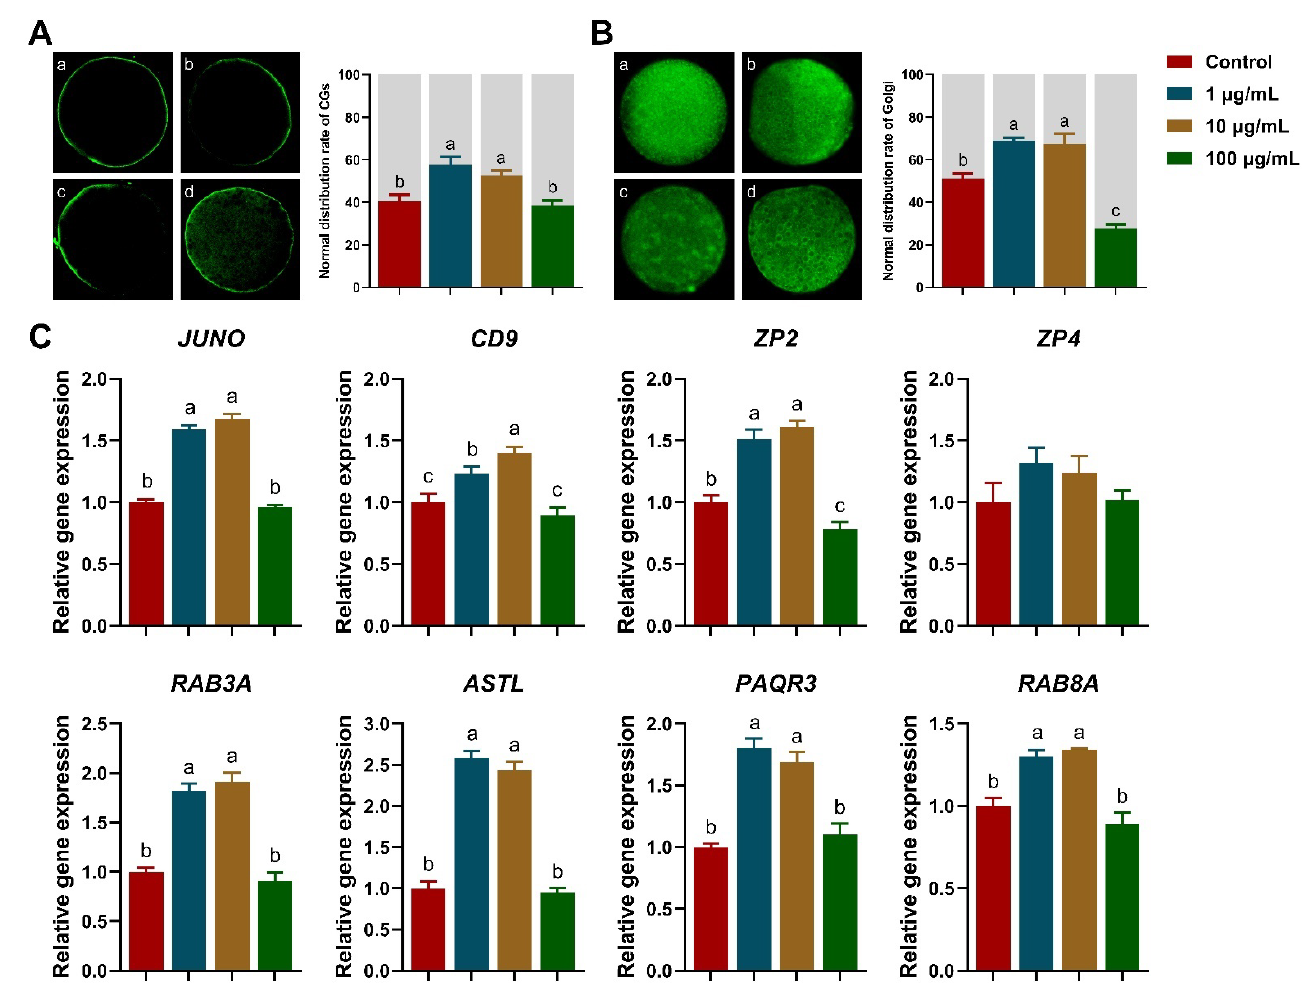
Figure 2. Effects of TA on the distribution of the cortical granule (CG) and Golgi apparatus (Golgi) in porcine oocytes. ( A ) CG distribution: ( a ) Peripheral CG distribution (normal); ( b , c ) homogeneous distribution (abnormal); ( d ) cortical distribution (abnormal). ( B ) Golgi distribution: ( a ) homogeneous distribution (normal); ( b–d) unequal distribution (abnormal). ( C ) Polyspermy, CG, and Golgi-related gene expression. Within the same indicator, bars with different letters are significantly different ( p < 0.05). Results are shown as the average ± SEM of at least three repeats of independent experiments. A total of 30 oocytes were analyzed per group in each replicate.